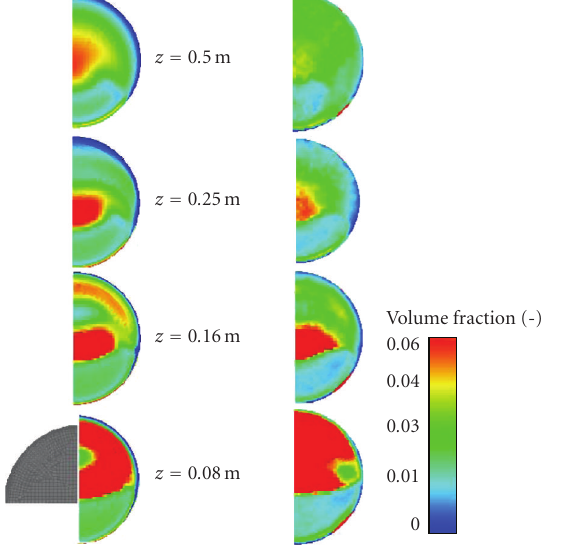
Figure 17: Calculated by Neptune CFD (left) and measured (right) gas volumetric fraction run 074 for di ff erent elevations (obstacle, symbolized in gray, is at z = 0 m and covers the “upper” part of the half-pipe cross-section